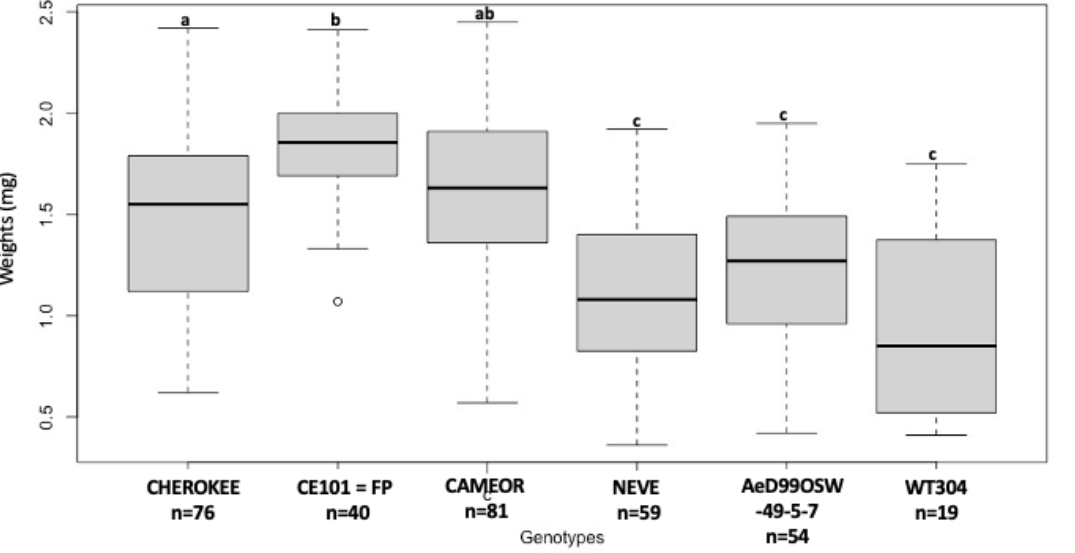
Figure 1. Larval body mass (8-day-old) of pea biotype, ArPo28, reared on different genotypes of P. sativum and on P. fulvum. Different letters indicate significant differences (one-way ANOVA, post-hoc comparisons using DGC, p < 0.05).